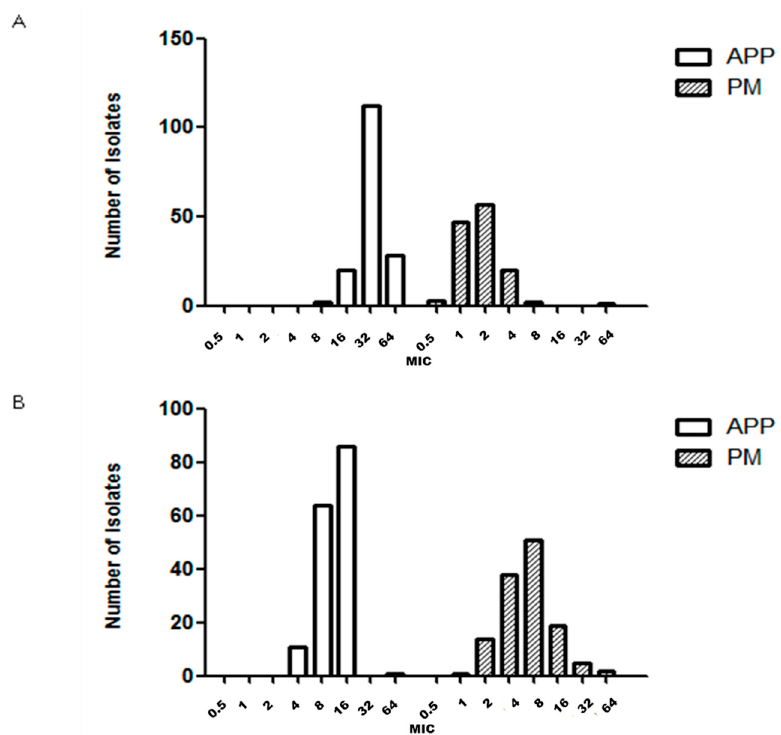
Figure 5. Minimum inhibitory concentration (MIC, µ g / mL) distribution of tulathromycin ( A ) and tilmicosin ( B ) for Actinobacillus pleuropneumoniae (APP) and Pasteurella multocida (PM) isolated from lungs of pigs with respiratory symptoms. Table 1. Actinobacillus pleuropneumoniae (APP), MIC 50 , MIC 90 , current recommended clinical breakpoints (CB) and antimicrobial susceptibility. The MIC 50 and MIC 90 were determined from the MIC distribution from 162 APP strains isolated from respiratory clinical cases. The antimicrobial susceptibility was calculated as the percentage of bacterial isolates below CB. Antimicrobial 100 1 All clinical breakpoints were obtained from Clinical and Laboratory Standards Institute (CLSI) M100 2018 and CLSI VETO8 4th ed., 2018, with the following clarifications: $ Schwarz et al. (2008) [36]. + Extrapolated from tetracycline. & MIC represented in the table is for trimethropin. Sulfamethoxazole/trimethropim ratio tested is 19:1.